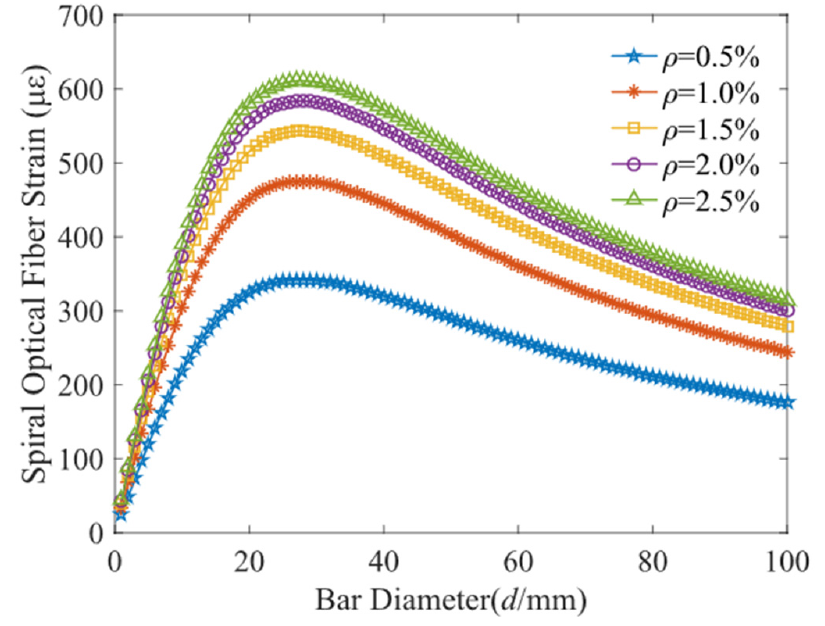
Figure 6. Fiber strain versus bar diameter.